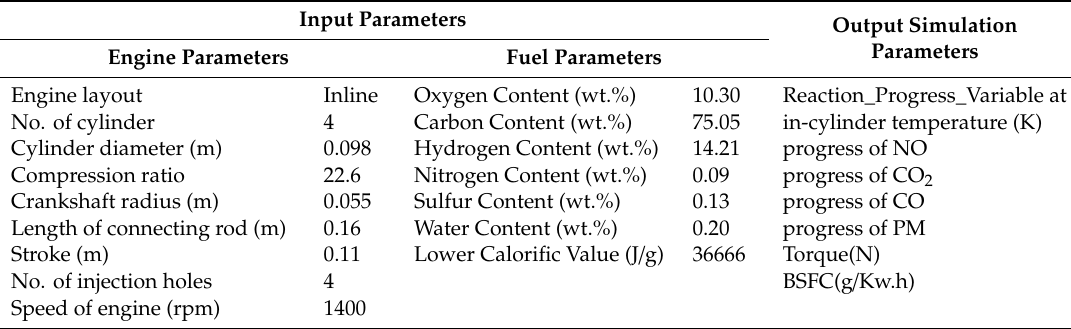
Table 4. Parameters of